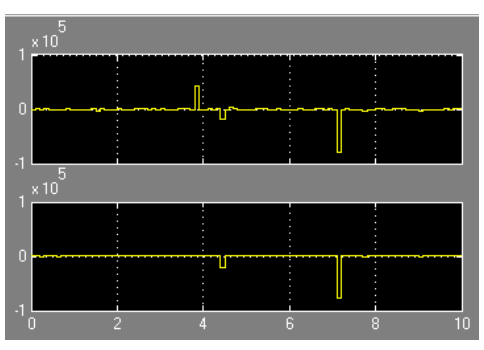
Figure 3. model with using ANN of Scope 2 ‘G 1 (u)’